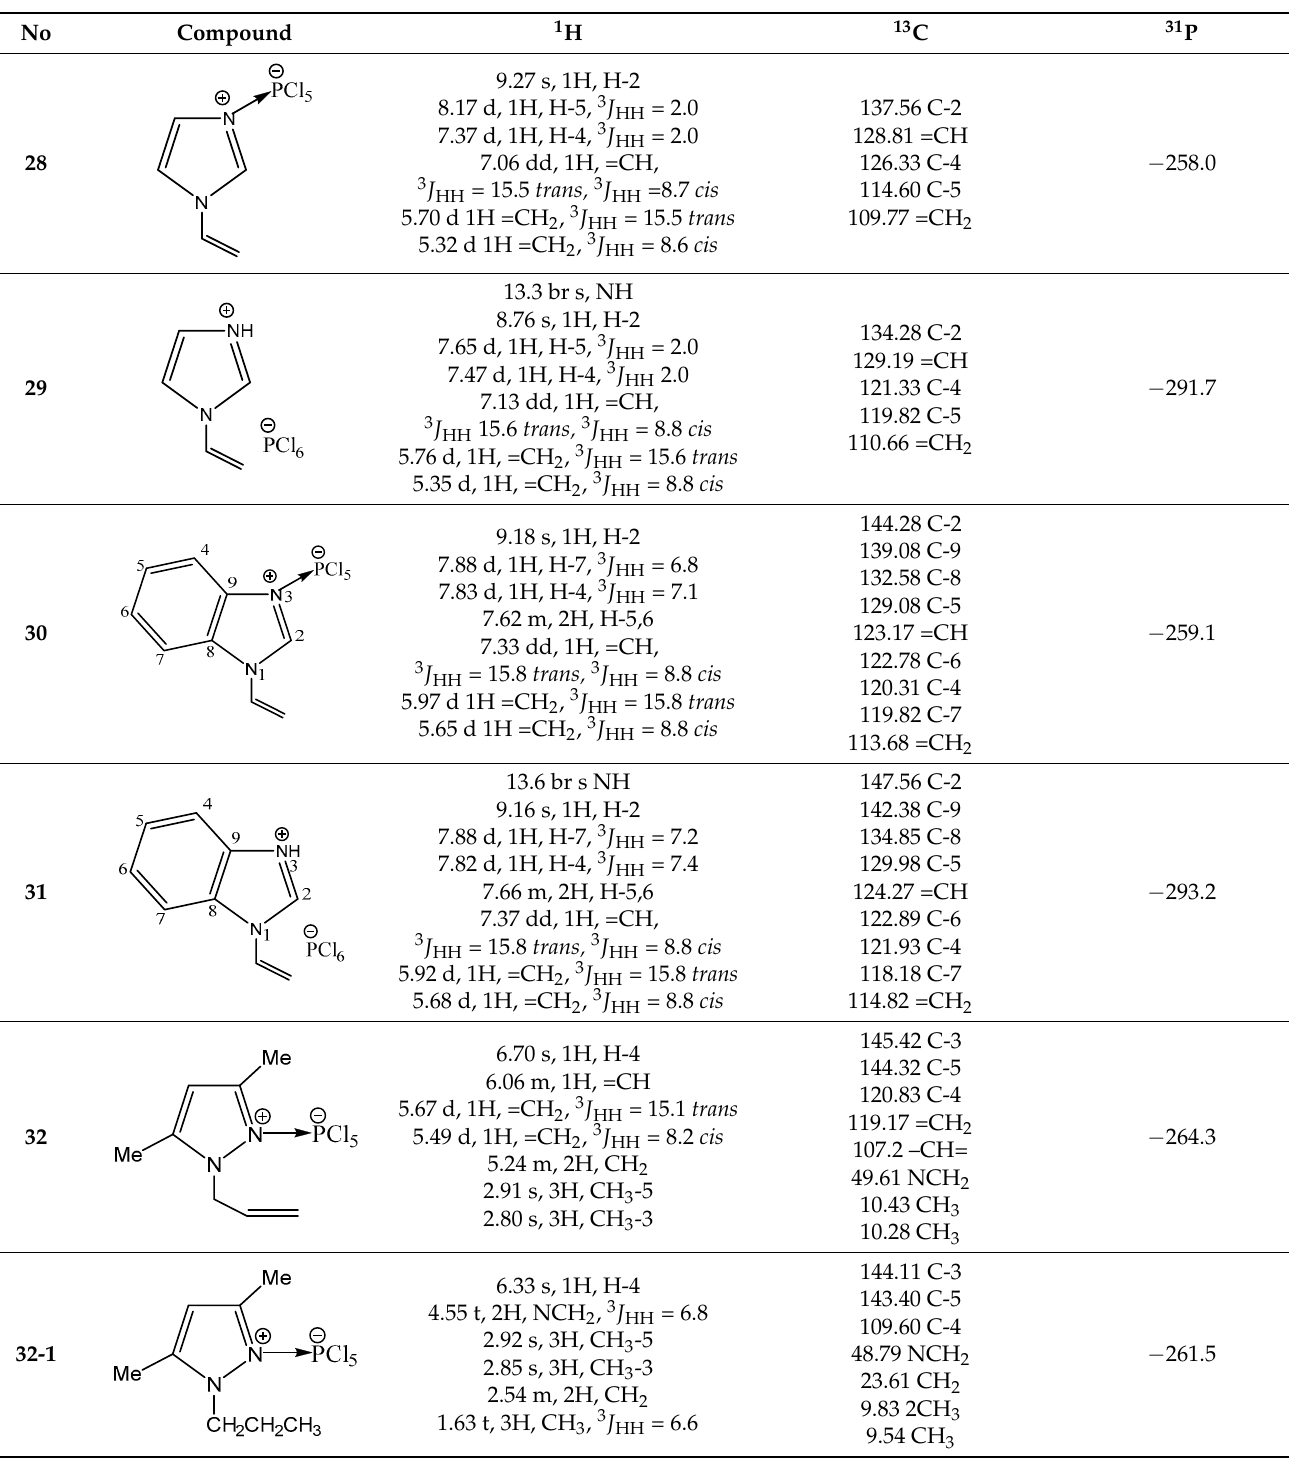
Table 8. 1 H, 13 C and 31 P NMR chemical shifts ( δ , ppm) and coupling constants ( J , Hz) of phos- phorylated azoles 28 – 36 (CDCl 3 ).